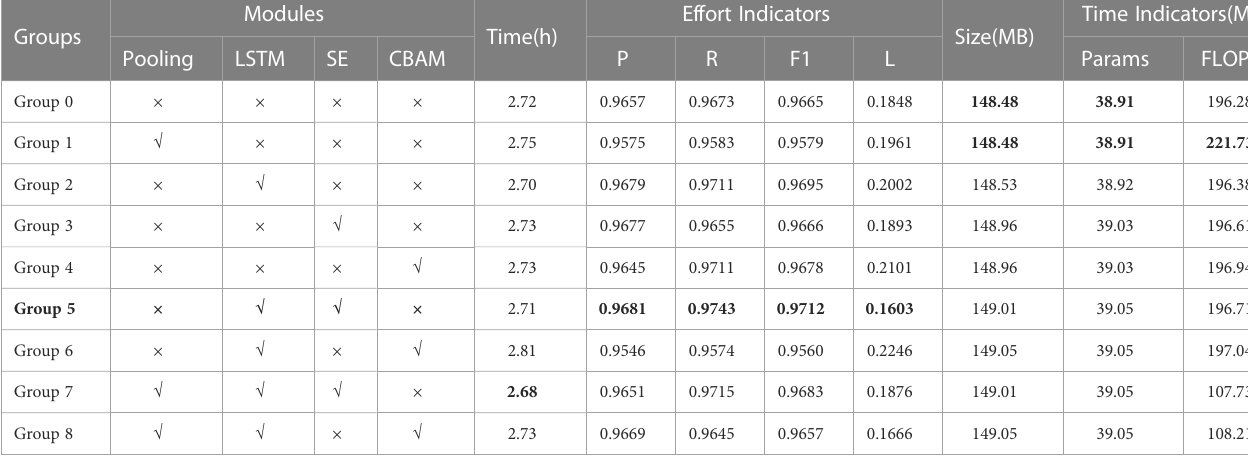
TABLE 4 Comparison of test results of each group.